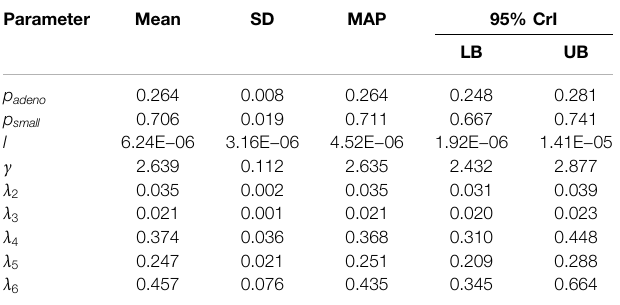
TABLE 3 | Posterior means, standard deviations, maximum-a-posteriori (MAP) estimate and 95% credible interval (CrI) of calibrated parameters of the microsimulation model of the natural history of